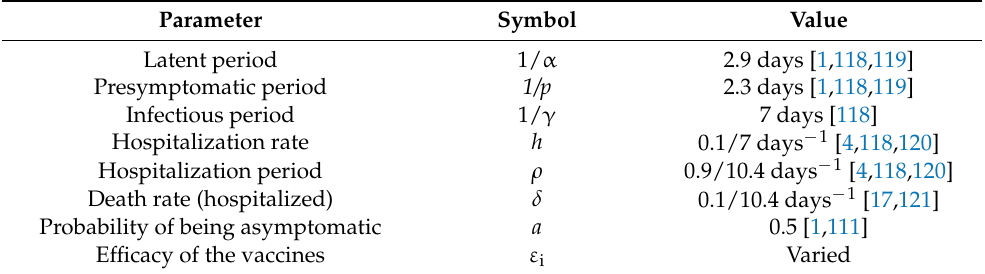
Table 2. Mean values of parameters used to perform numerical simulations of the different